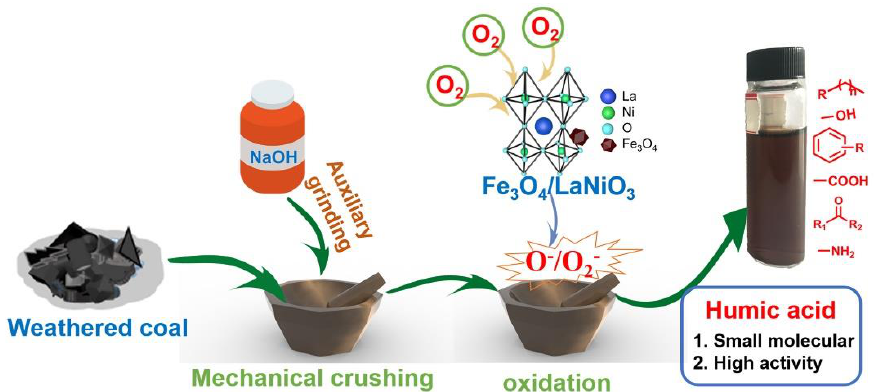
Figure 12. The mechanisms for the oxidation of weathered coal by Fe 3 O 4 /LaNiO 3 catalysts to obtain humic acids.